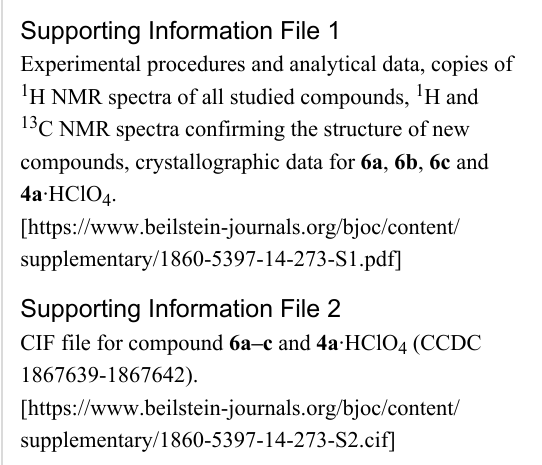
Increasing the number of OMe groups facilitated the proton transfer to the imino function by up to 90%. As a result, studied compounds can be considered as superbasic imines. In one case, we were able to experimentally observe the simultaneous out - inversion and protonation of the 1-NMe 2 group for the first